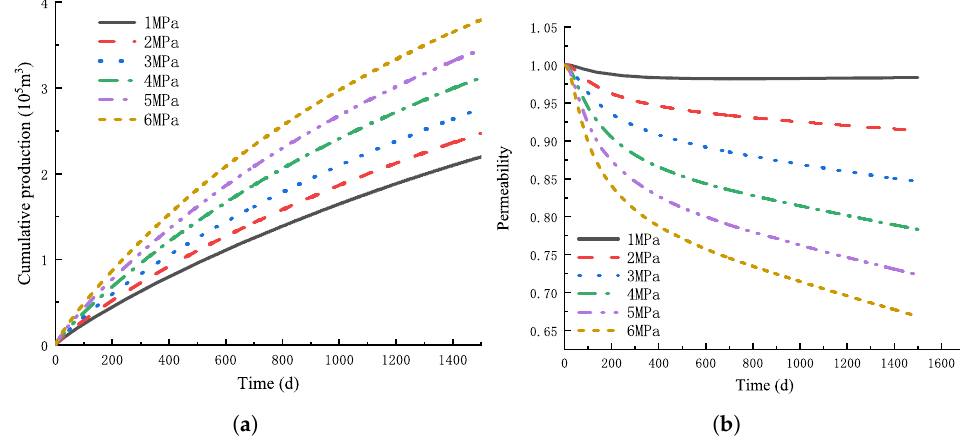
Figure 14. ( a ): Cumulative production. ( b ): Permeability change at point B.